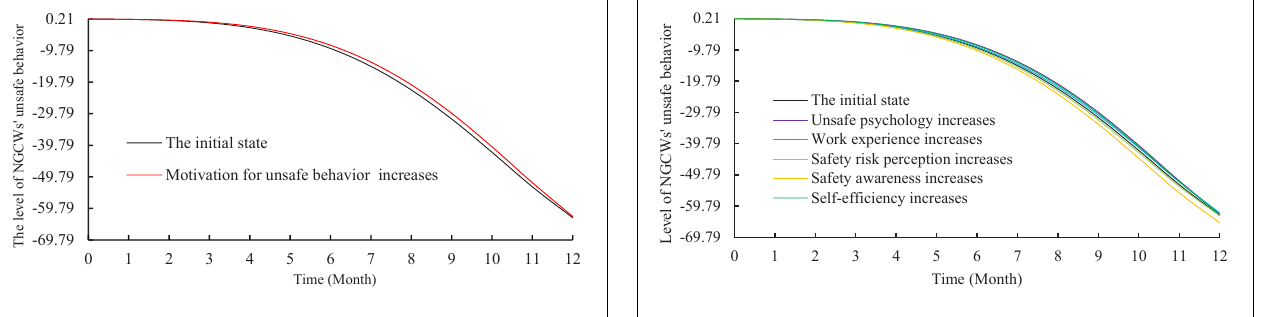
FIGURE 6 | Simulation of the effect of individual factors on unsafe behavior.